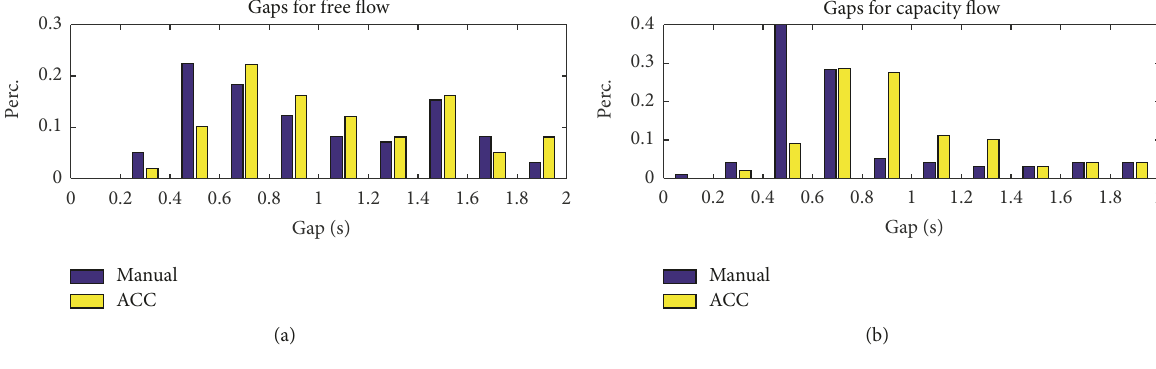
Figure 2: Vehicle time gaps found adapted from Gorter [6].